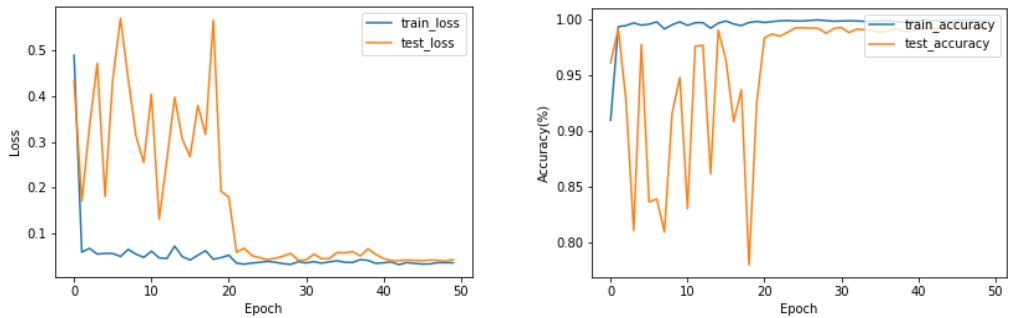
Figure 9. The loss and accuracy curves during training and testing on the Myo Dataset. when the training reaches convergence, there is no phenomenon where the accuracy of the training set is high and the accuracy of the test set is low, which is over-fitting.